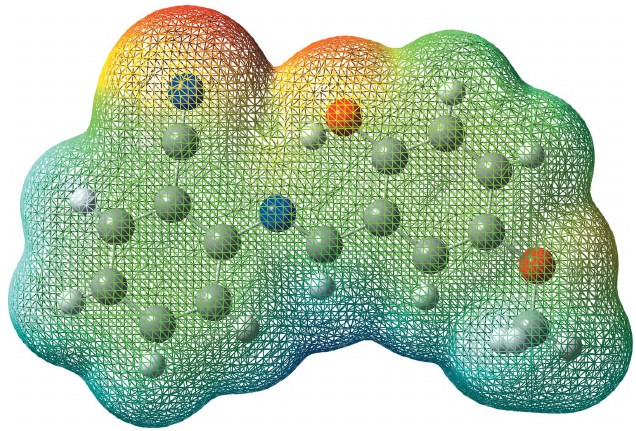
Figure 5 Total electron density mapped over the molecular electrostatic potential